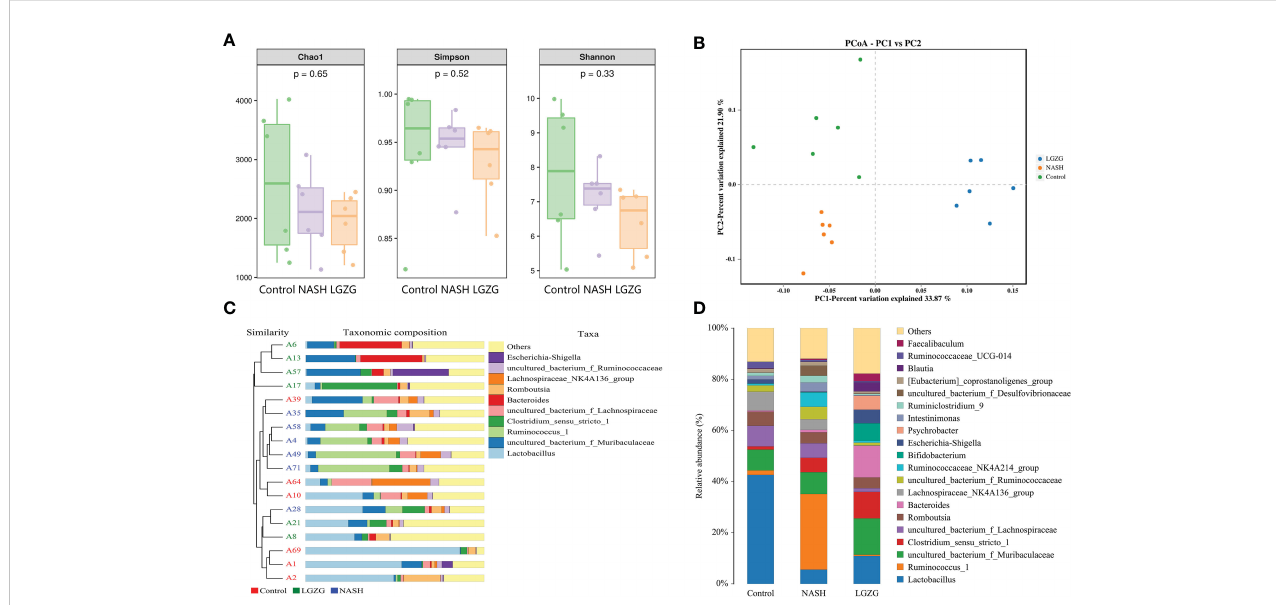
FIGURE 3 Effect of the LGZG on diversity and composition of gut microbiota. (A) Alpha-diversity analysis with Chao 1, Simpson, and Shannon indexes; the p values were calculated using the Kruskal-Wallis test for three group comparisons, (B) Principal coordinate analysis (PCoA) among the Control, NASH, LGZG groups, n=6 individuals/group, (C) UPGMA tree of three groups. A1, A2, A10, A39, A64, and A69 represent samples in the Control group, A4, A28, A35, A49, A58, and A71 represent samples in the NASH group, and A6, A8, A13, A17, A21, and A57 represent samples in the LGZG group. The bars in different colors represent different taxa at genus levels, (D) The relative abundances of gut microbiota at genus levels in the Control, NASH, and LGZG groups; the X-axis represents different groups and the Y-axis represents the relative abundance (%), while bars in different colors represent different taxa at genus